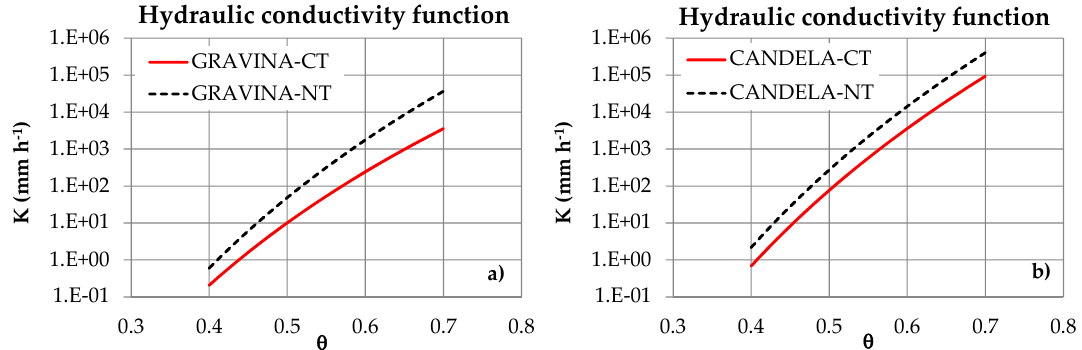
Figure 6. Hydraulic conductivity functions obtained with BEST-steady at Gravina ( a ) and Candela ( b ) sites.